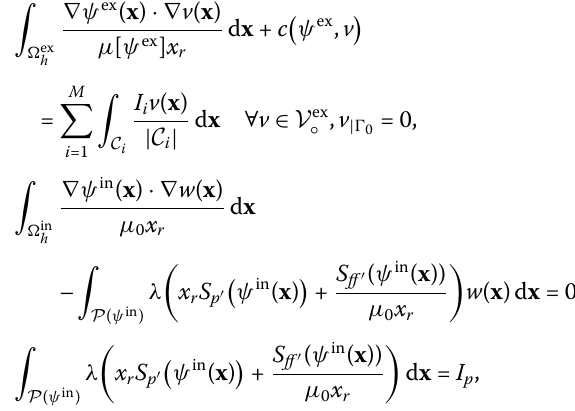
Figure 8 Setting for Validation of MEM. We may choose (cid:9) in γ ex is contained in the layer of elements of T in which define γ in . Otherwise, we say that (cid:9) in overlap with (cid:9) ex h